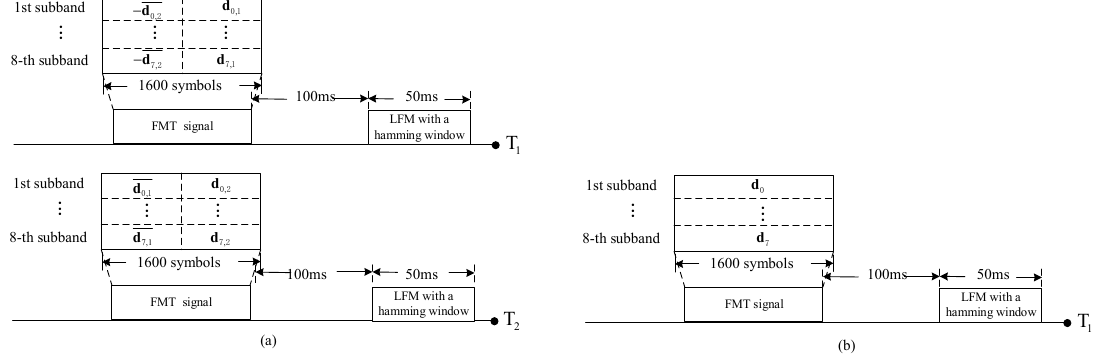
Figure 9. Diagram for transmit signals of three methods: ( a ) the proposed method; ( b ) SISO method and SIMO method.